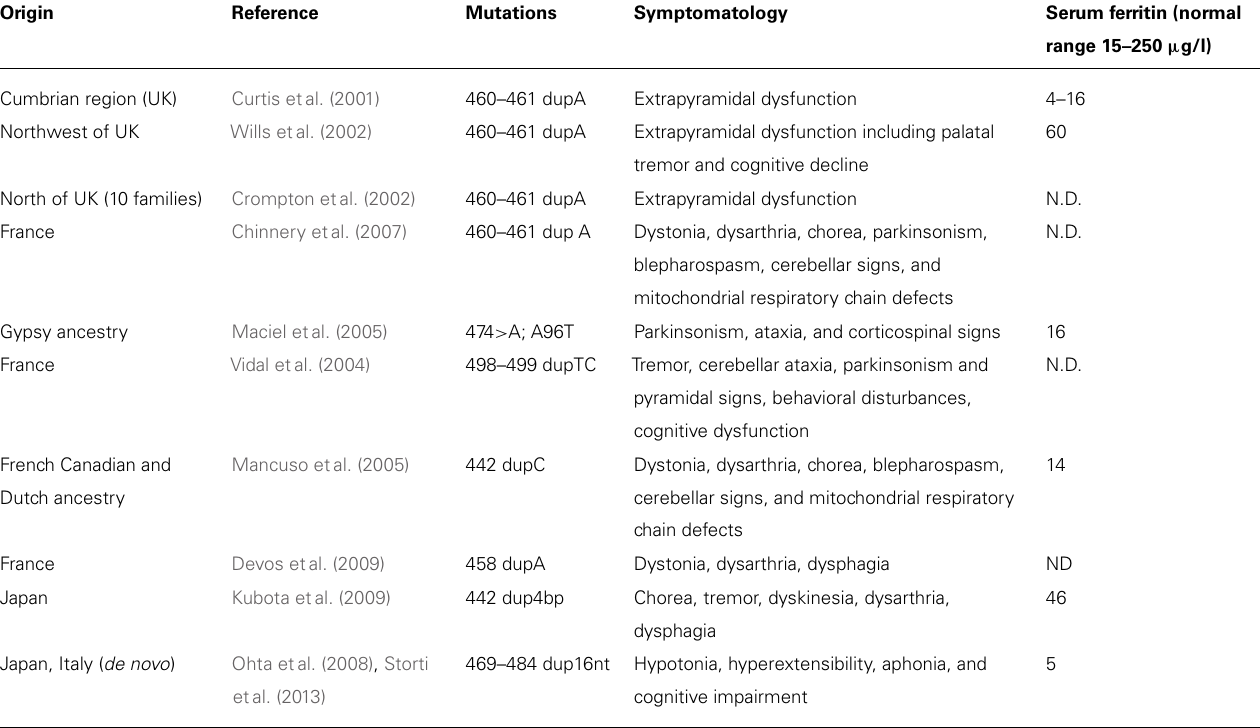
Table 3 | Reported cases of